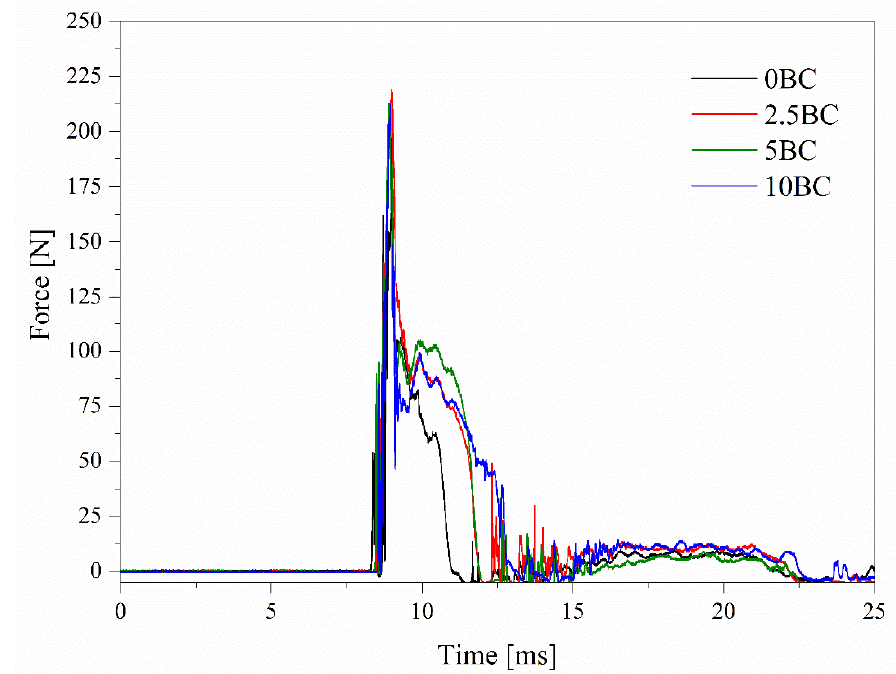
Figure 6. The load–time curves of the investigated composites.